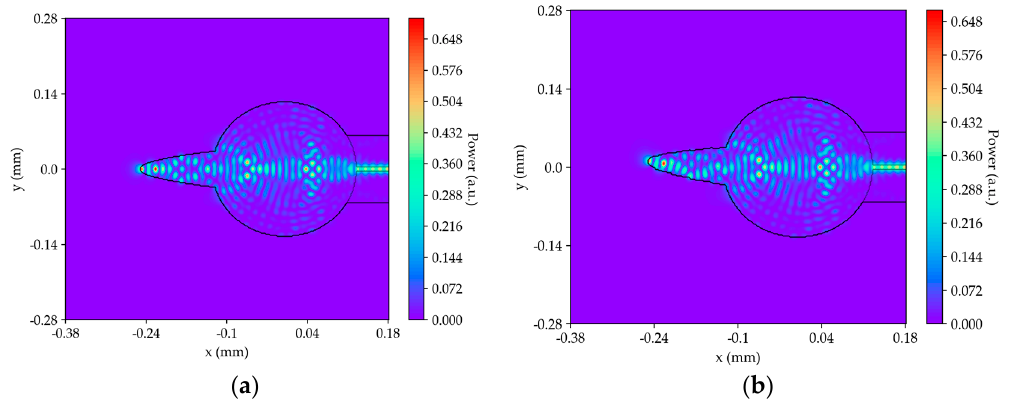
Figure 6. Frame 177 from two simulations: ( a ) Straight fiber tip and ( b ) curved fiber tip.